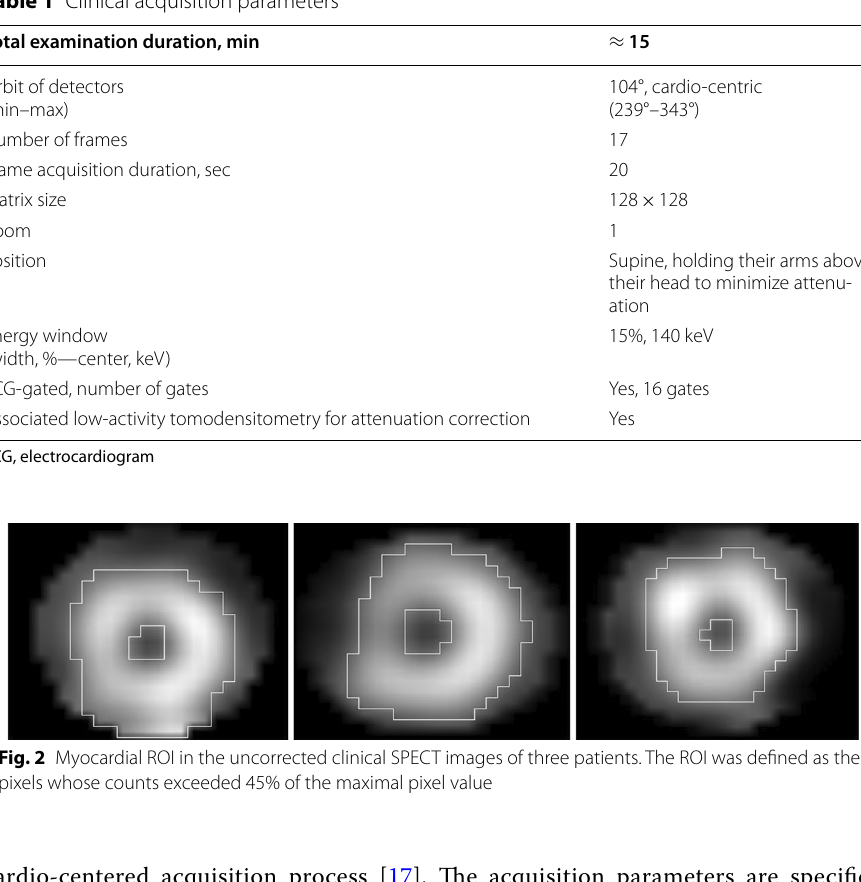
Table 1 Clinical acquisition parameters